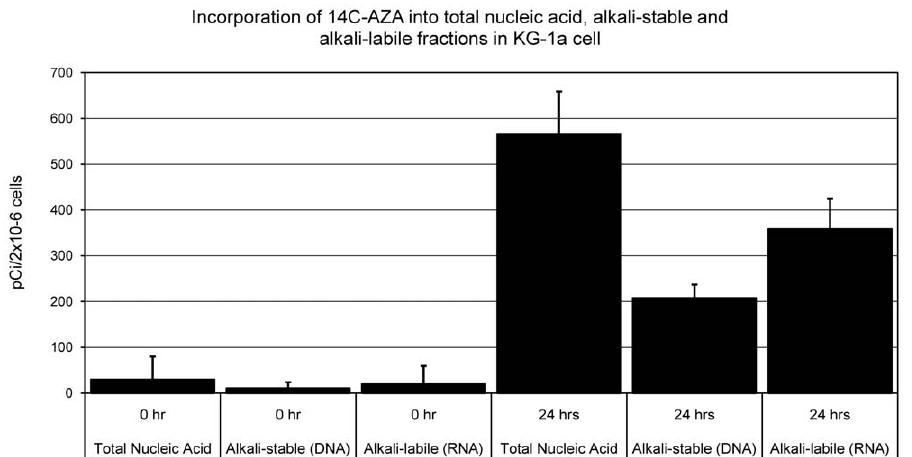
Figure 2. AZA incorporates into RNA and DNA of KG-1a cells. KG-1a cells were treated with 0.3 m M radiolabeled AZA ([ 14 C]-AZA) for 24 hours. The amount of AZA incorporated into total nucleic acid, DNA, and RNA was quantified as described previously. Standard error of the mean was determined from 3 independent experiments, including triplicate wells per experiment. AZA = azacitidine.